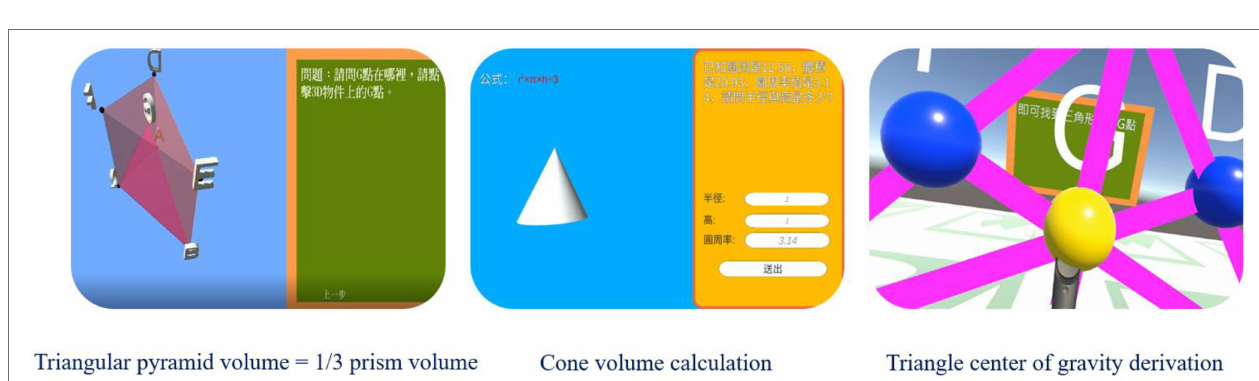
FIGURE 2 | Three learning units in the virtual reality immersive learning mathematics geometry